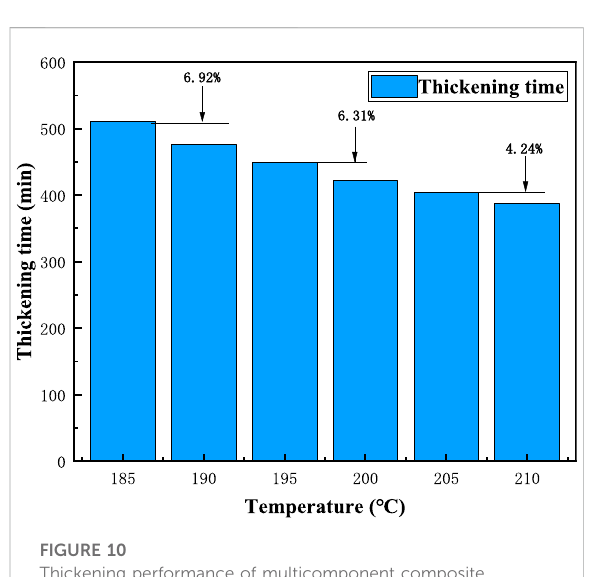
FIGURE 11 Effect of BFs addition on corrosion depth of HA-composite emulsion cement